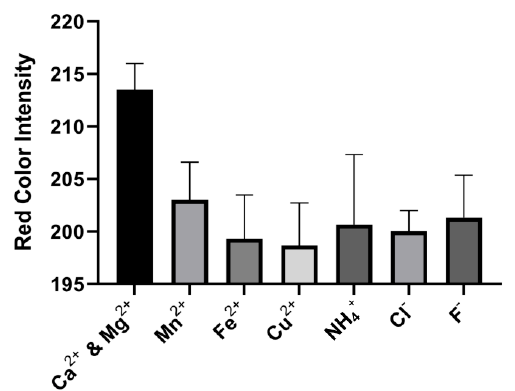
Figure 10. Interference test of the common ions in water in comparison with the limit of detection (0.1 mM) of the combined calcium and magnesium ions by the device. For each of the interference ions, the concentration of 0.1 mM was used for the comparison. Each data point is the mean of the three individual experiments ± standard deviation.